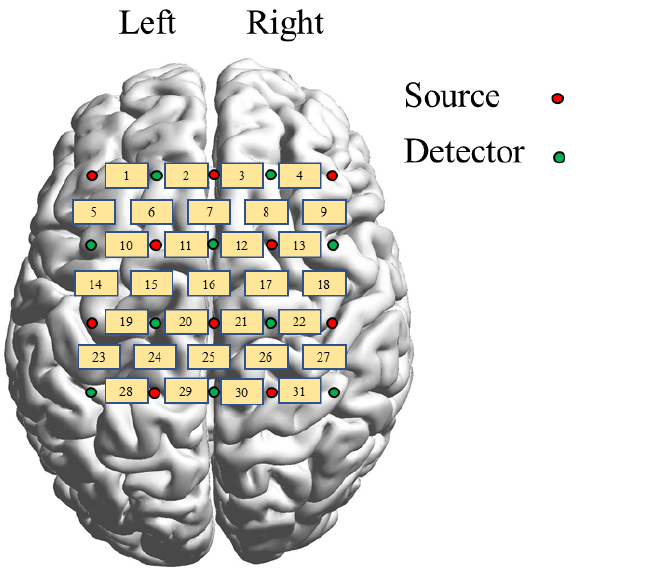
Figure 2. The optical probes are arranged in channels on the surface of the standard human